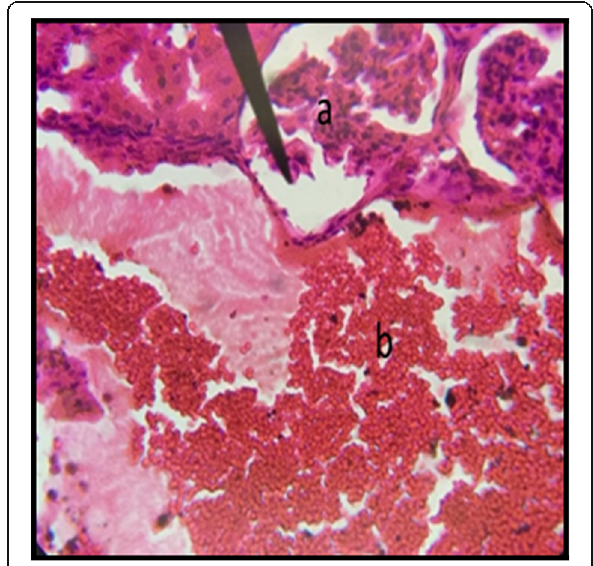
Fig. 9 Kidney Section of Male Rat (200 mg/kg/day) X400. a normal glomerulus, b rupture of the basement membrane along with the infiltration of blood cells